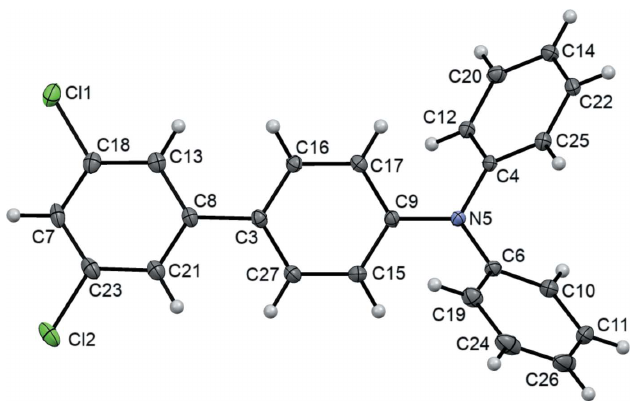
Figure 1 The asymmetric unit of the title compound with atom numbering. Displacement ellipsoids are drawn at the 50% probability level.